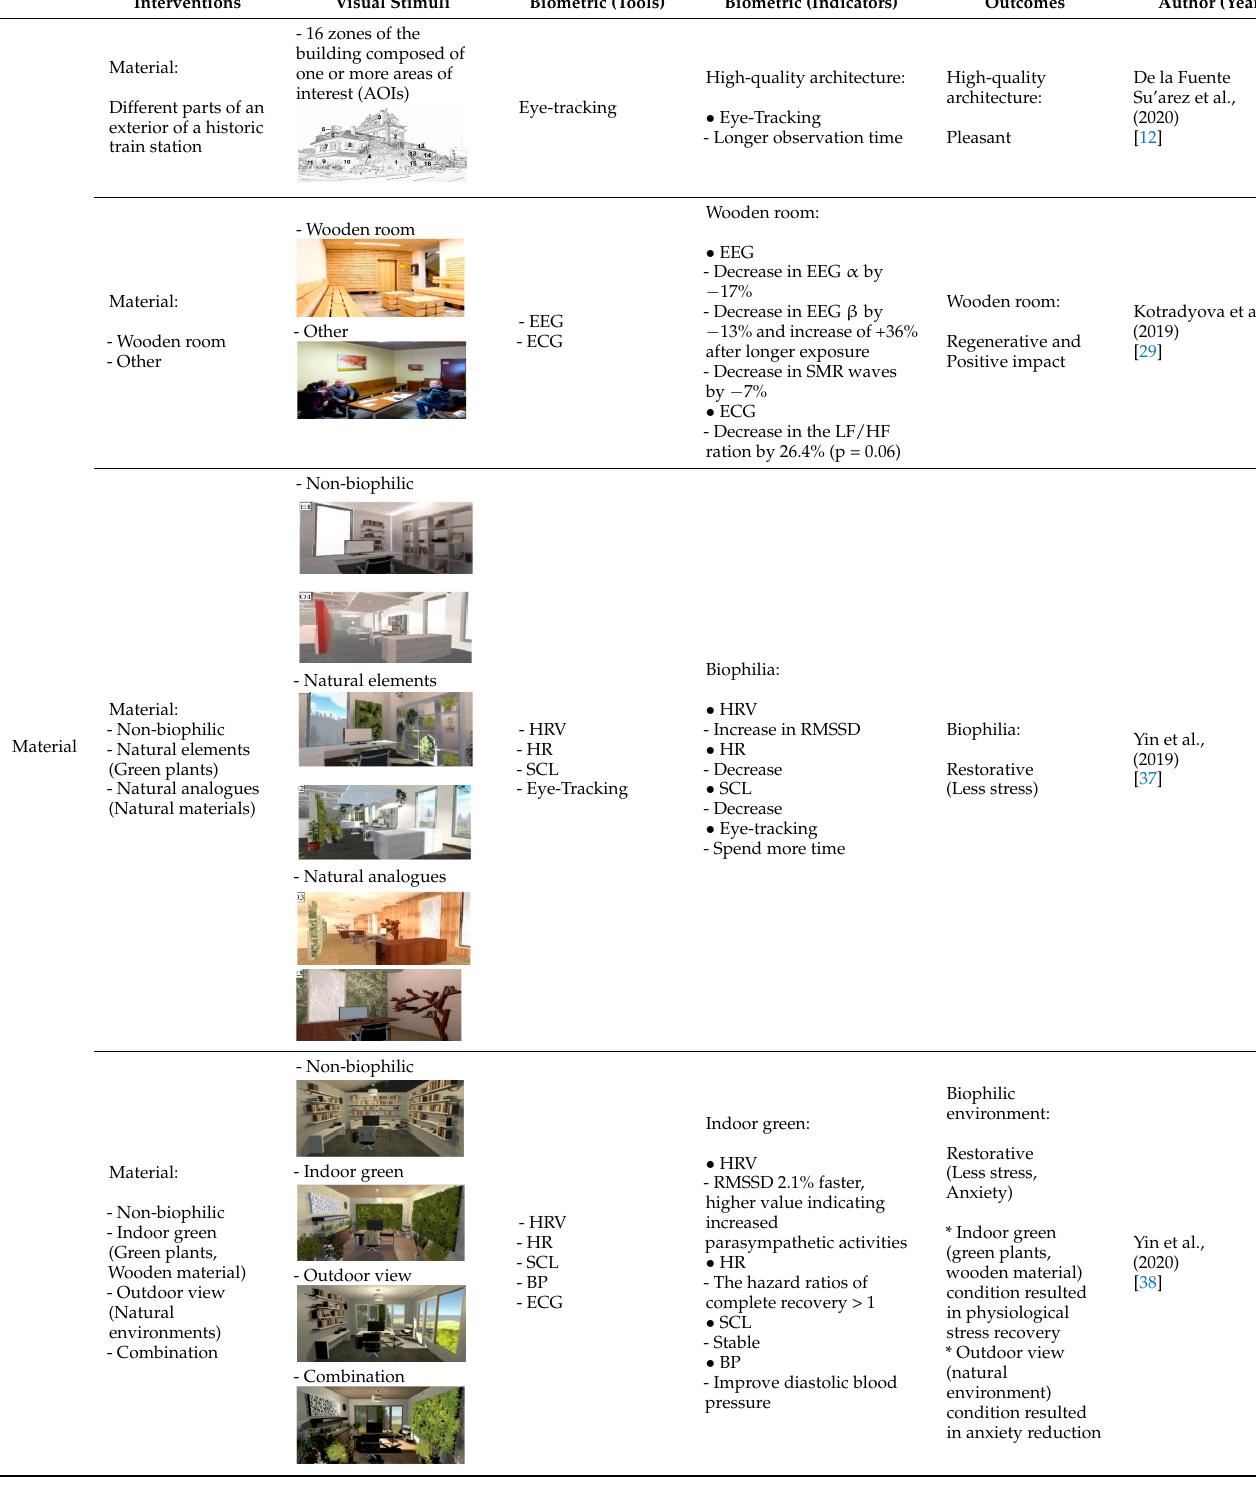
Blue: Blue: Blue: • Heart rate • Heart rate • Heart rate -Decrease -Decrease -Decrease